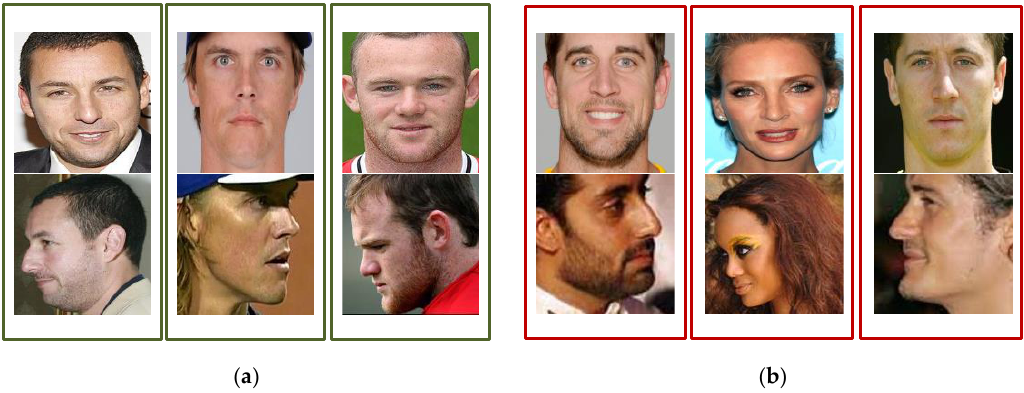
Figure 13. Test protocol for Celebrities in Frontal Profile dataset frontal- profile(CFP_fp) mode. ( a ) Face verification for the same objects. ( b ) Face verification for different objects.